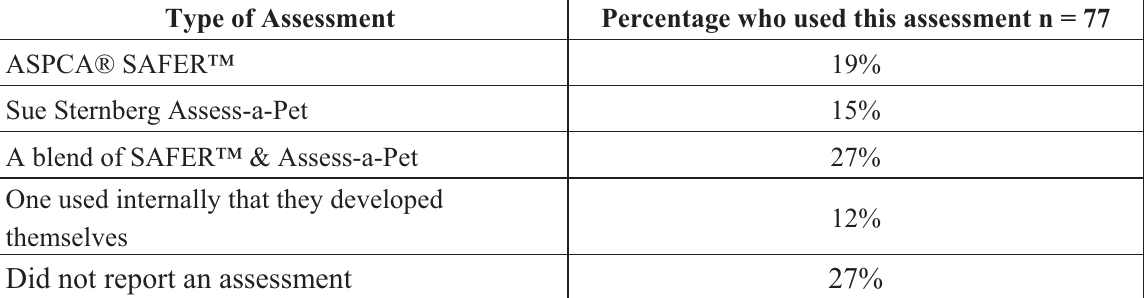
Table 6. Responses to the open-ended question: “Please describe the assessment that your shelter uses on